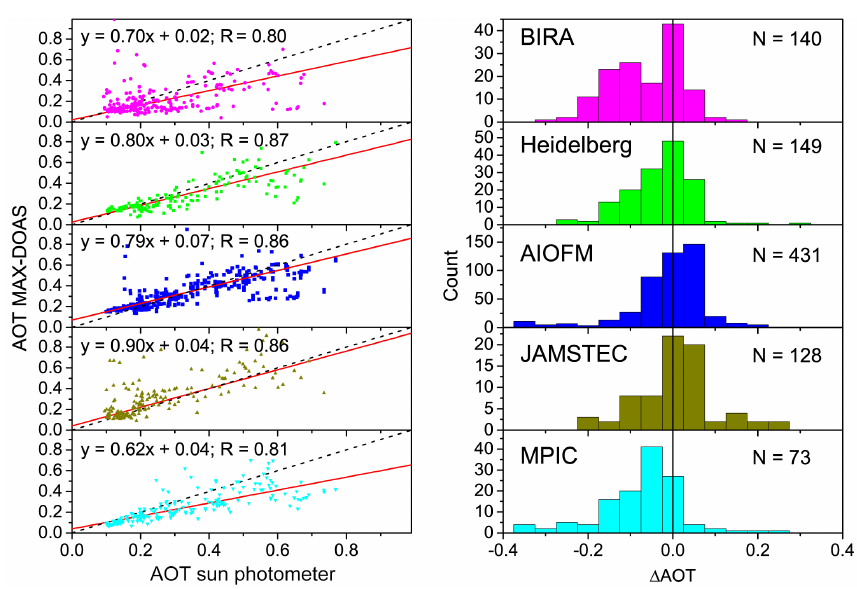
Figure 11. Left panels: correlation between AOT from the different groups and from the sun photometer. The red line shows the linear fit and the dashed line the 1 : 1 line. Right panels: histograms of the difference in AOT (MAX-DOAS – sun